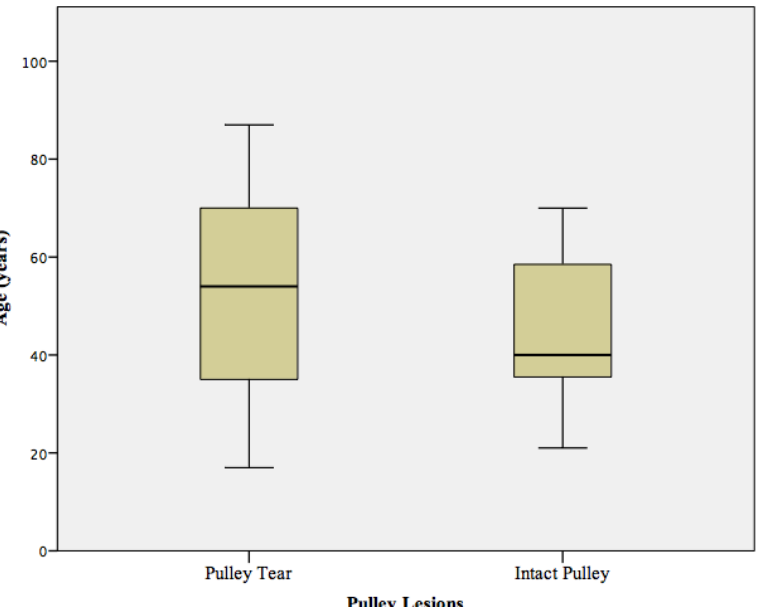
Figure 3. Mean age of patients with acute lesions of the biceps pulley (mean age 52 ± 12 years) compared to patients with intact biceps pulley (mean age 44 ± 14 years, p = 0.023). The mean age of patients with acute pulley lesions was significantly higher compared to patients without pulley lesions ( p =